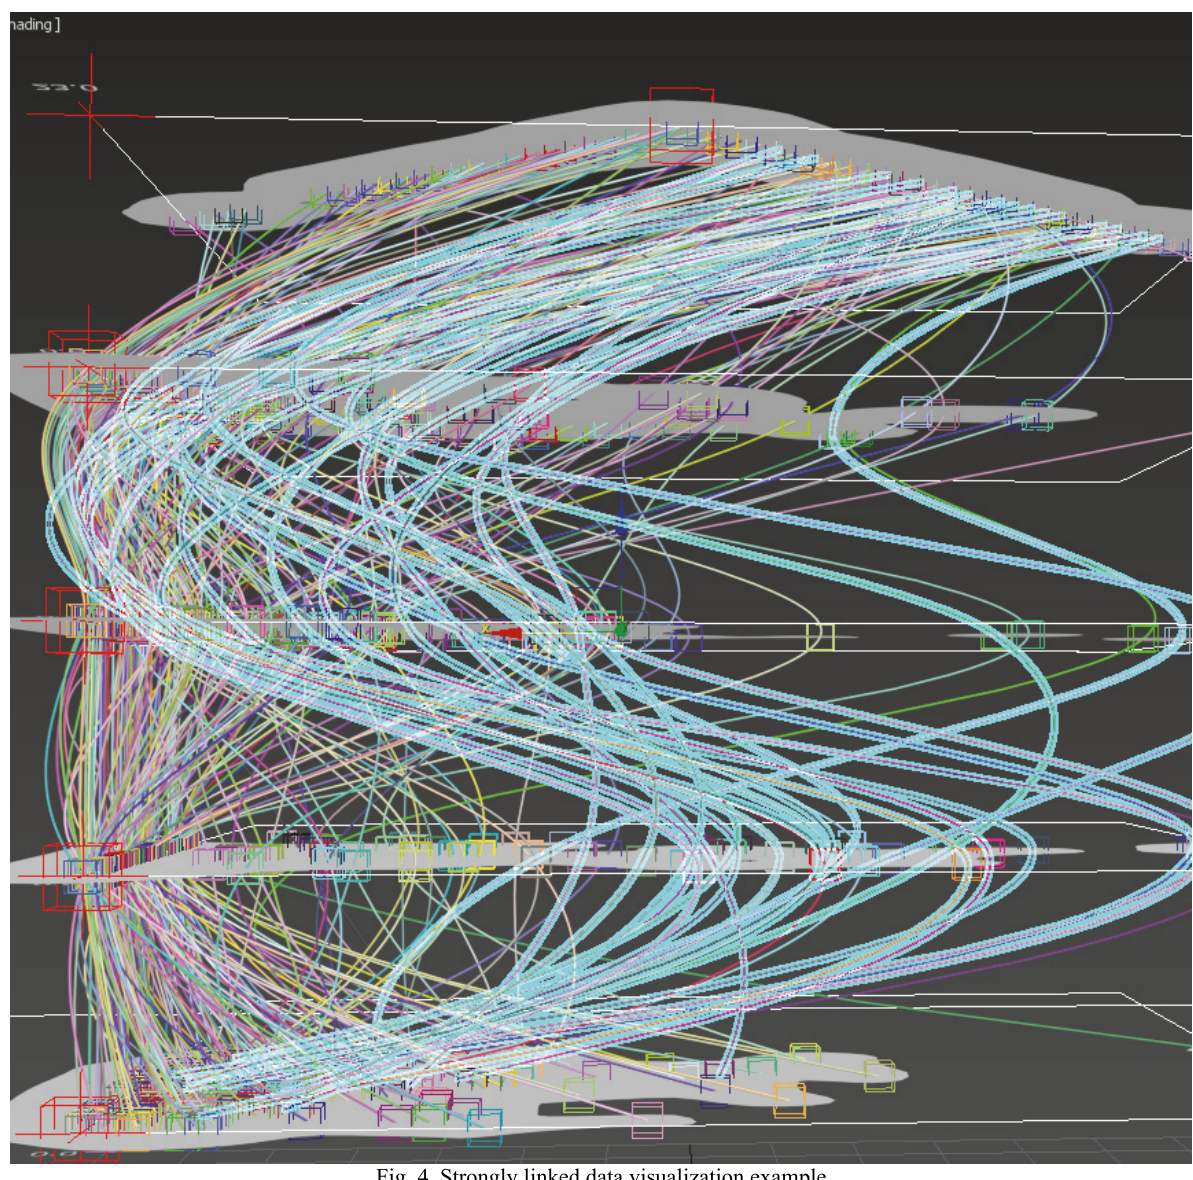
Fig. 4. Strongly linked data visualization